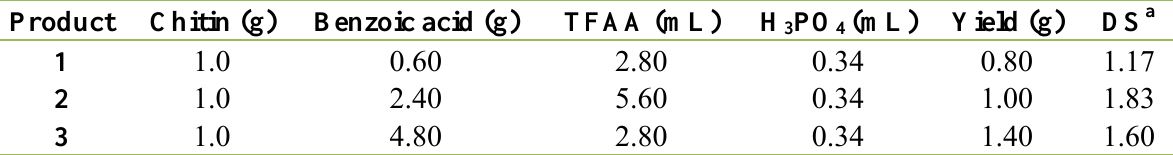
Table 1. Preparation of chitin benzoates from chitin and benzoic acid in the presence of TFAA/H PO 3 4